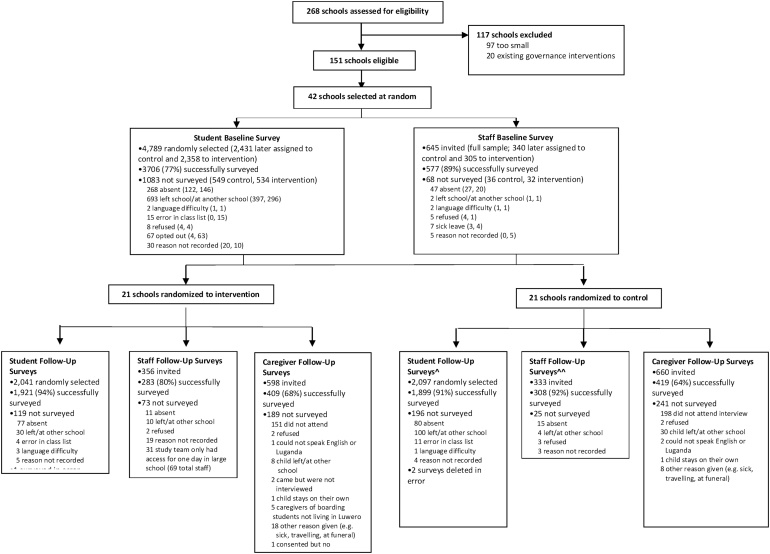
Flow chart showing trial profile.^In a previous publication (Devries, Child, Elbourne, Naker, & Heise, 2015), we inadvertently omitted mention of 2 student follow-up surveys in the control group which were erroneously deleted.^^In a previous publication (Kayiwa et al., 2017), we inadvertently counted 329 eligible staff in the control group at follow-up when we should have counted 333.